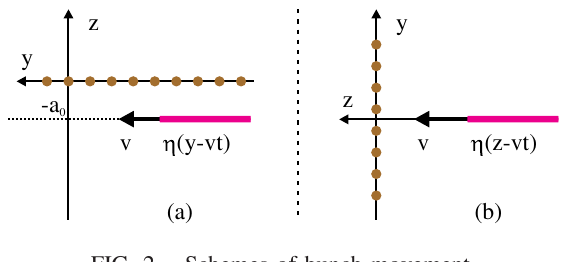
FIG. 2. Schemes of bunch